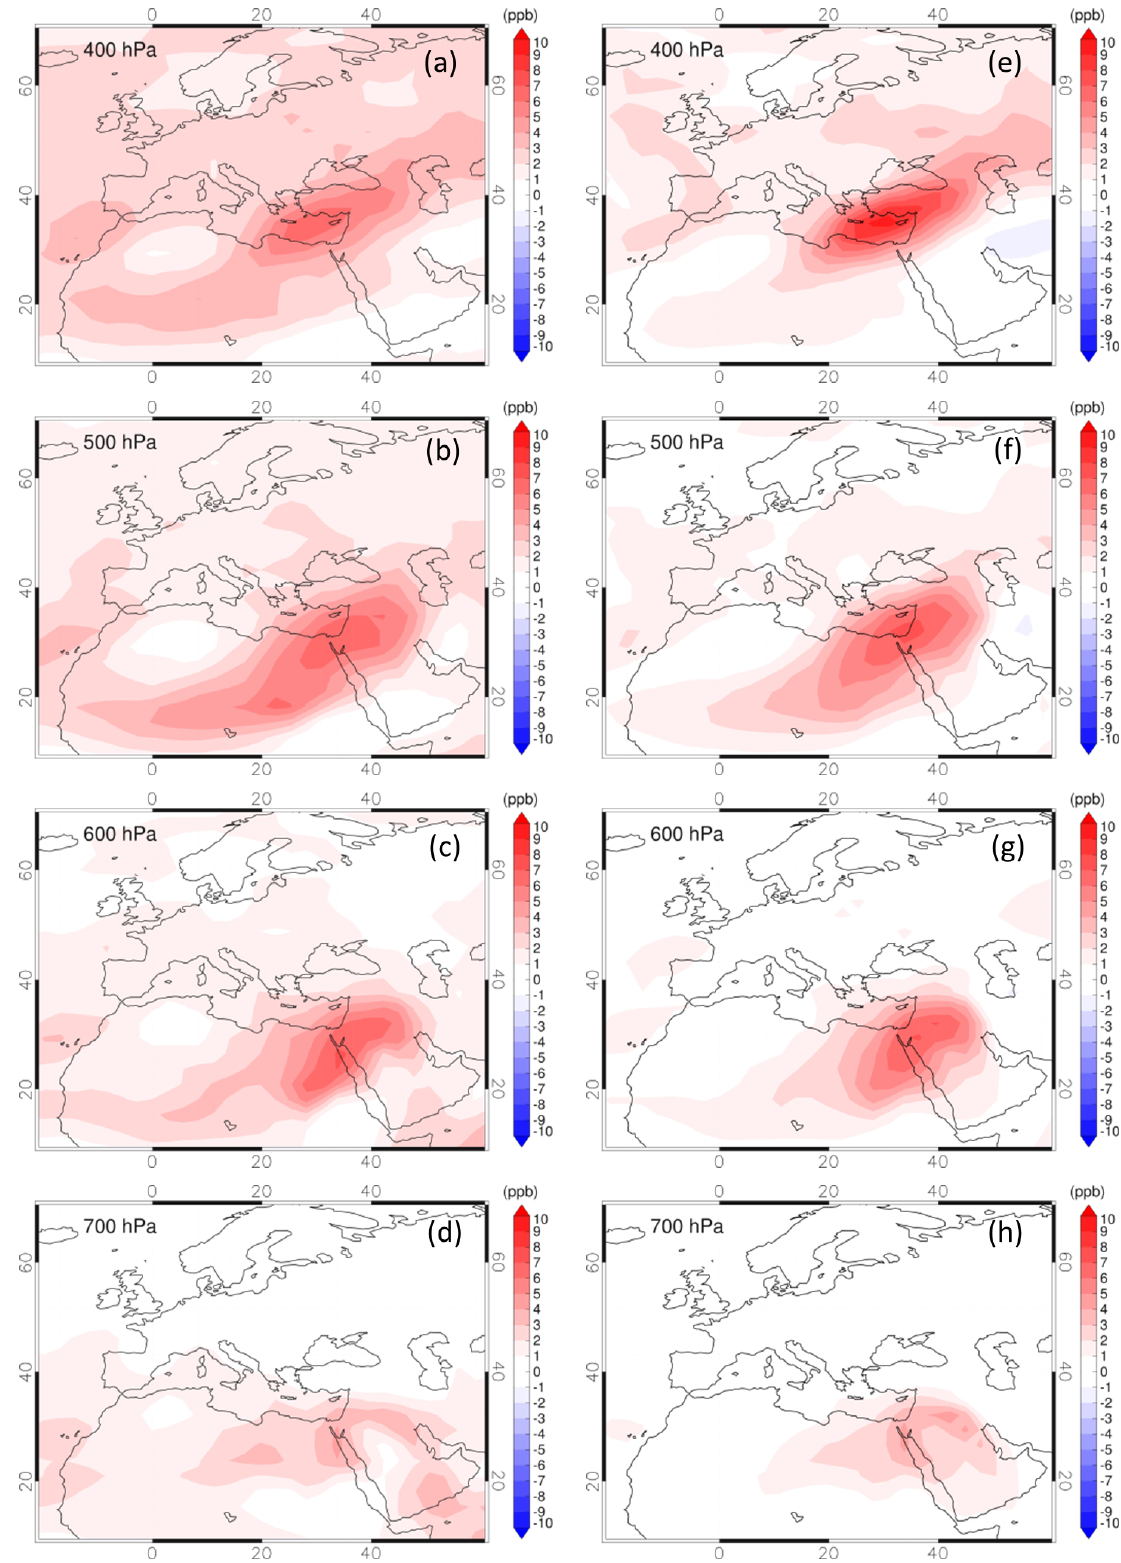
Figure 5. Anomalies of EMAC-simulated ozone (left) and stratospheric ozone tracer (right) during the selected fold events from the remain- der summer time steps at 400hPa (a, e) , 500hPa (b, f) , 600hPa (c, g) and 700hPa (d, h) .